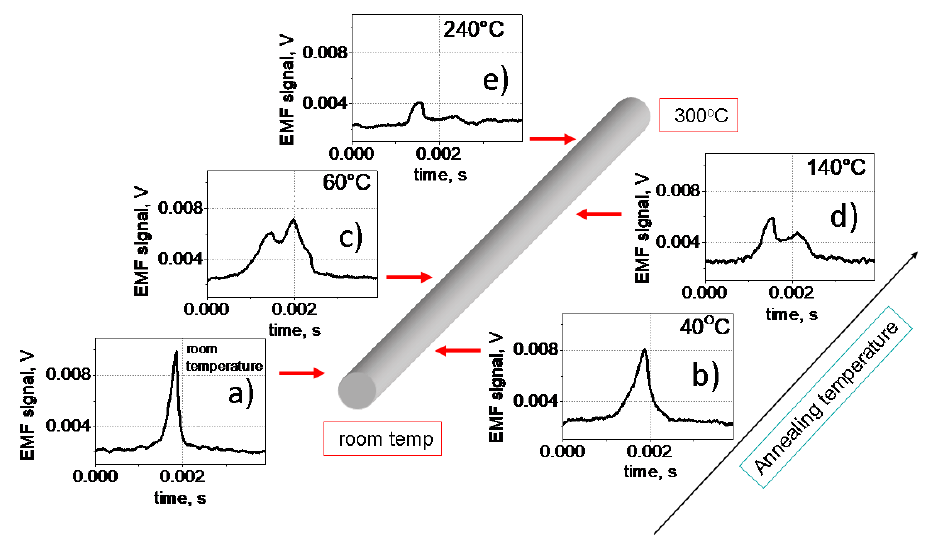
Figure 3. Distribution of EMF peak along the sample length. ( a ) room temperature, ( b ) 40 °C, ( c ) 60 °C, ( d ) 140 °C, ( e ) 240